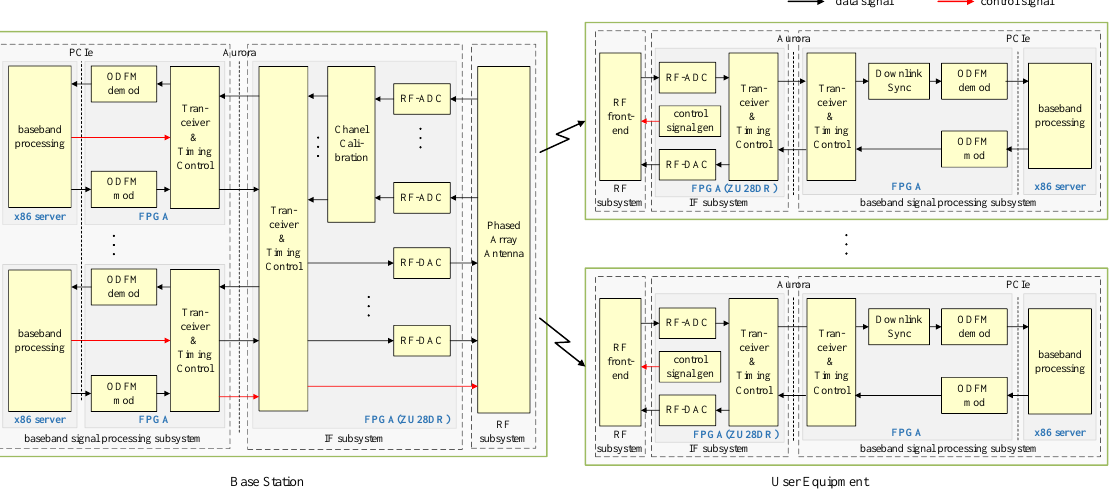
Figure 1. Overview of our proposed XL-MIMO testbed in the multi-UE